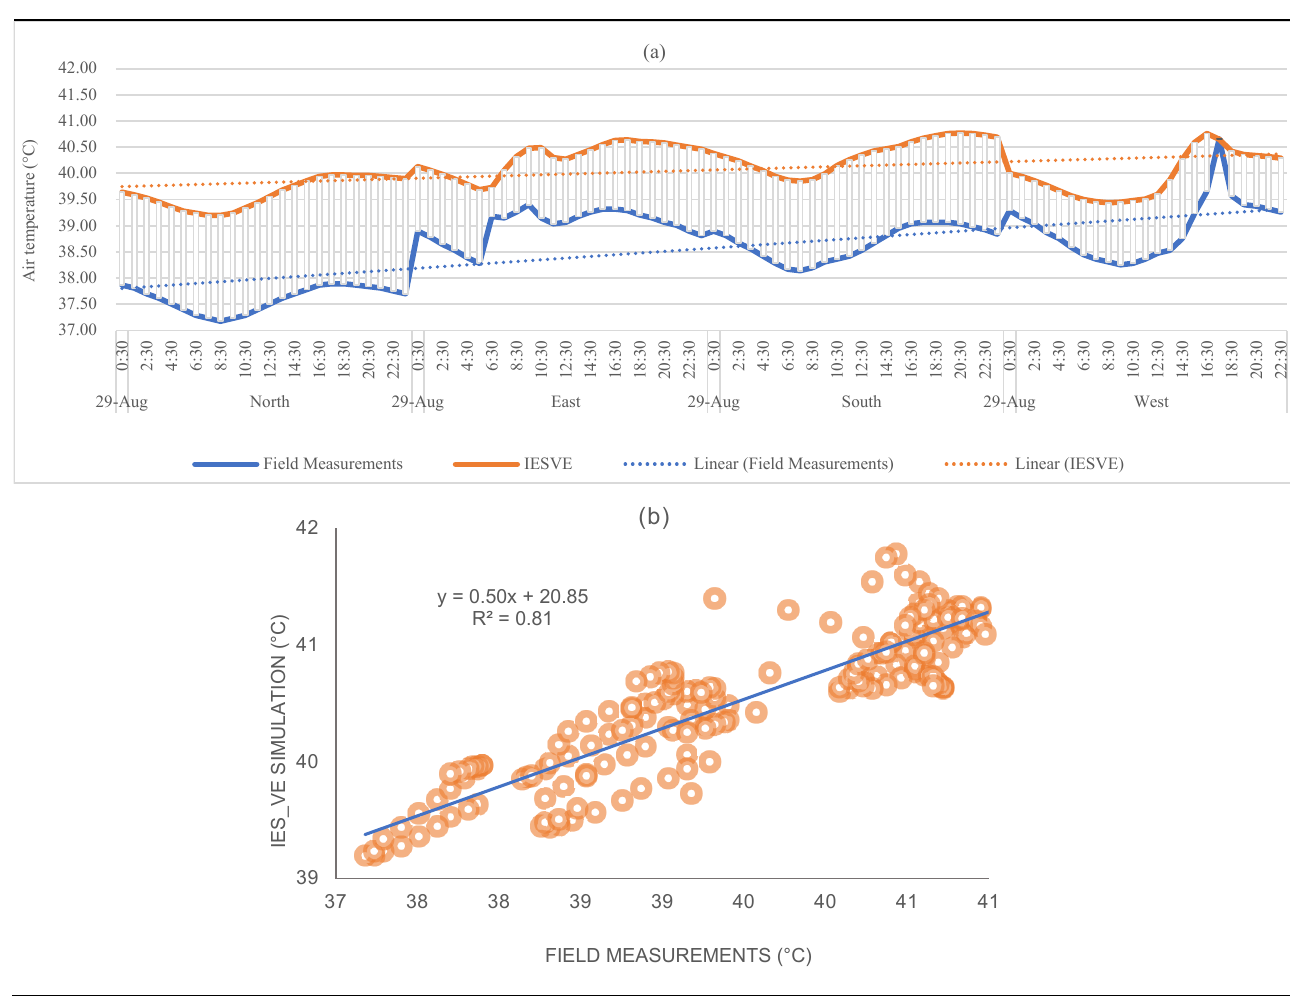
Figure 5. Filed measurements data ( a ) for whole day in all orientations, and the scatter plot ( b ) represents the correlation coefficient between Field data and simulation result.